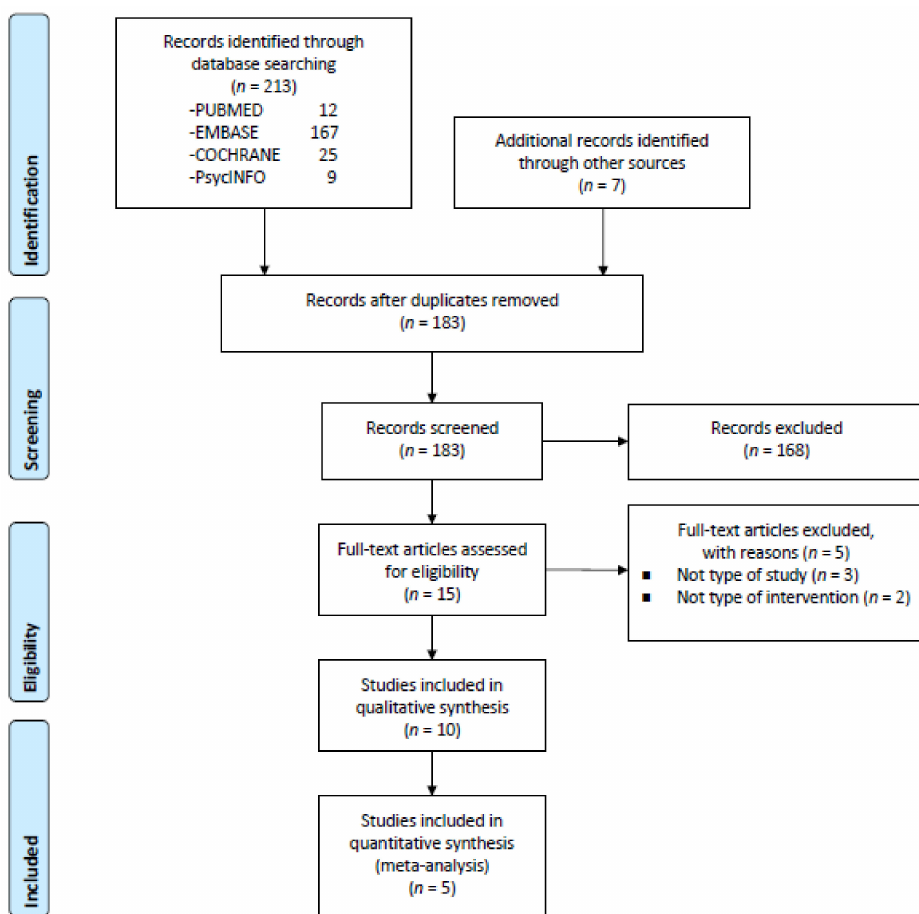
Figure 1. PRISMA flow chart of study